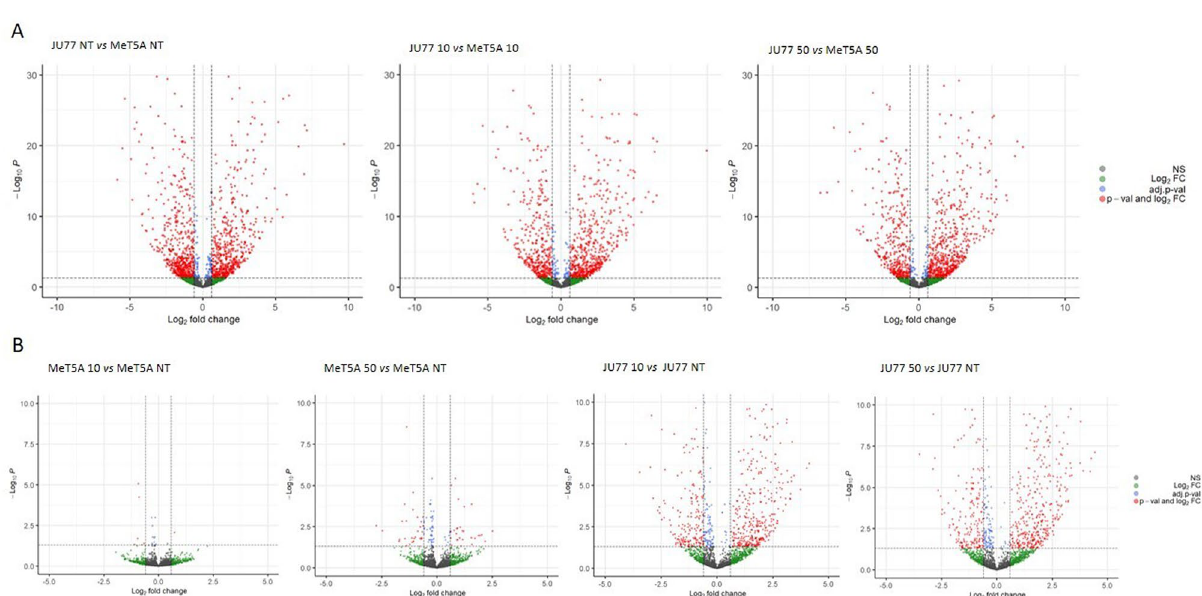
Figure 3. Volcano plots showing the differentially expressed miRNAs and tRNA-derived ncRNAs between: ( A ) JU77 (human malignant mesothelioma) vs. MeT-5A (human normal mesothelium); ( B ) Untreated vs. FE fibers treated JU77 and